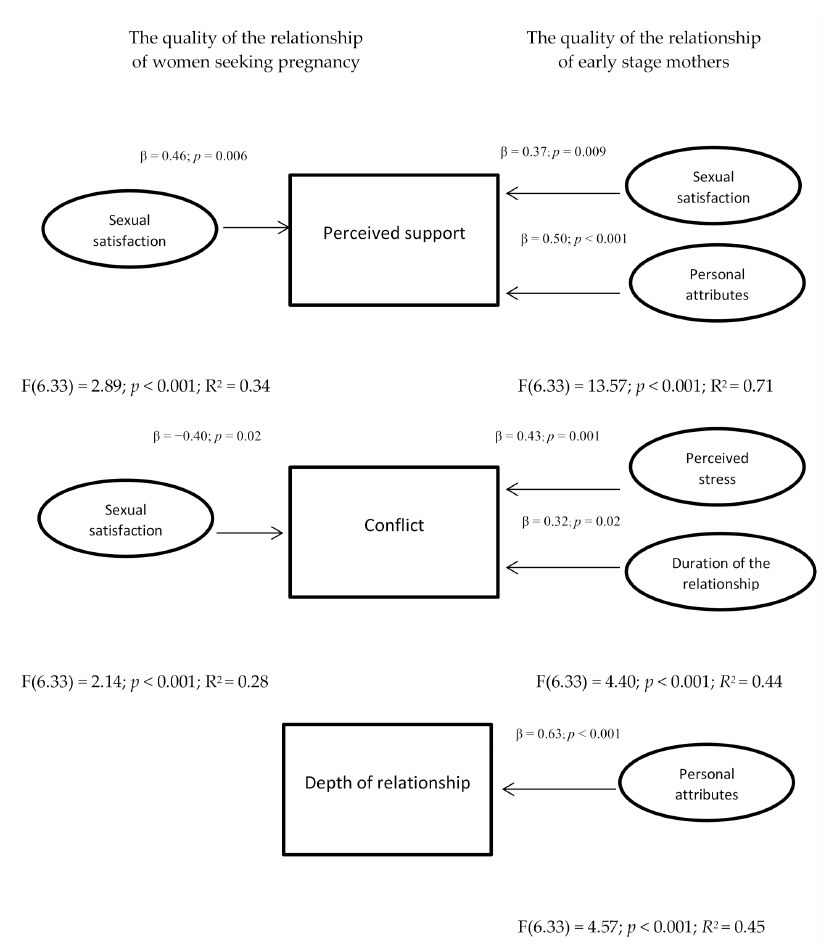
Figure 1. Comparison of predictors of quality of relationship between childless women seeking pregnancy and early-stage